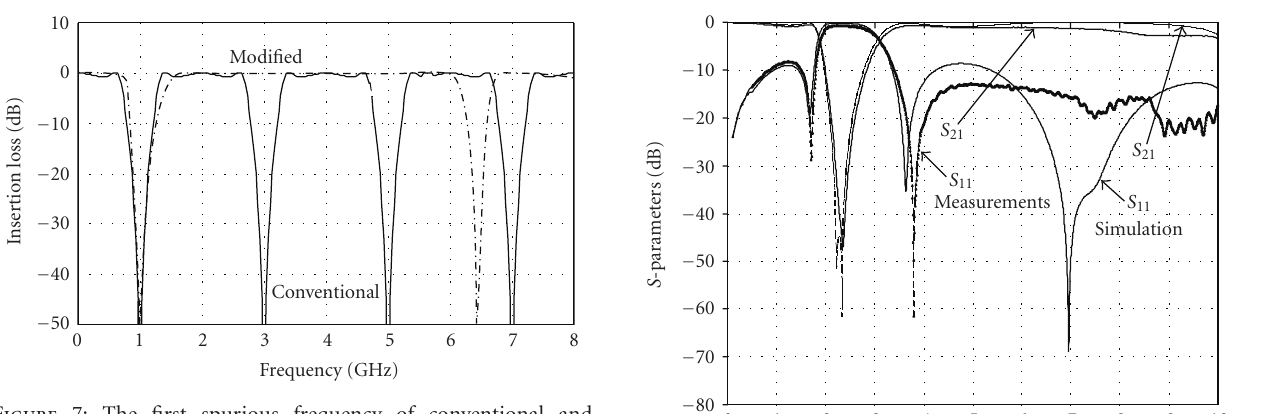
Figure 7: The first spurious frequency of conventional and modified BSFs.